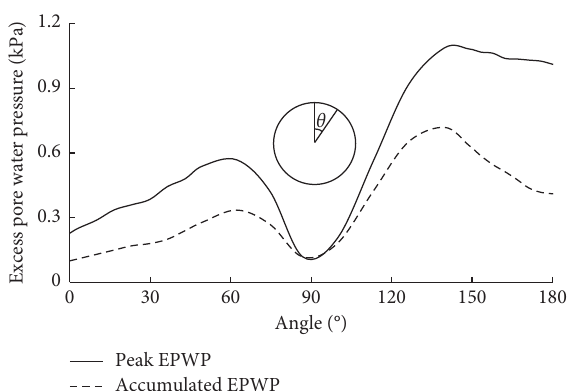
Figure 27: EPWP distribution around the